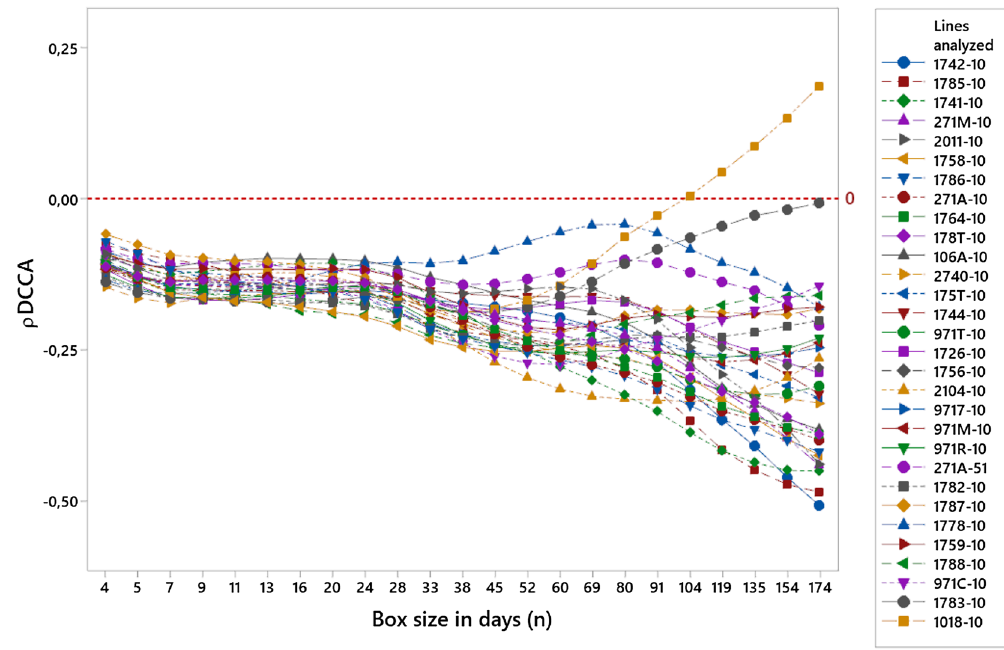
Figure 1. Cross-correlation between the number of people with disabilities (PWD) and elderly passengers riding the public bus system (in the 30 lines analyzed) and rainfall (mm) in the city of São Paulo, Brazil, from January 2015 to